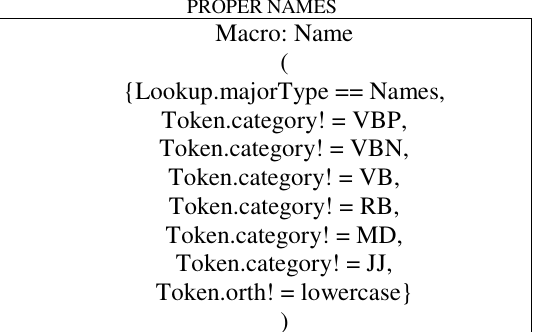
TABLE 4: MACRO RULE FOR THE IDENTIFICATION OF PROPER NAMES Macro: